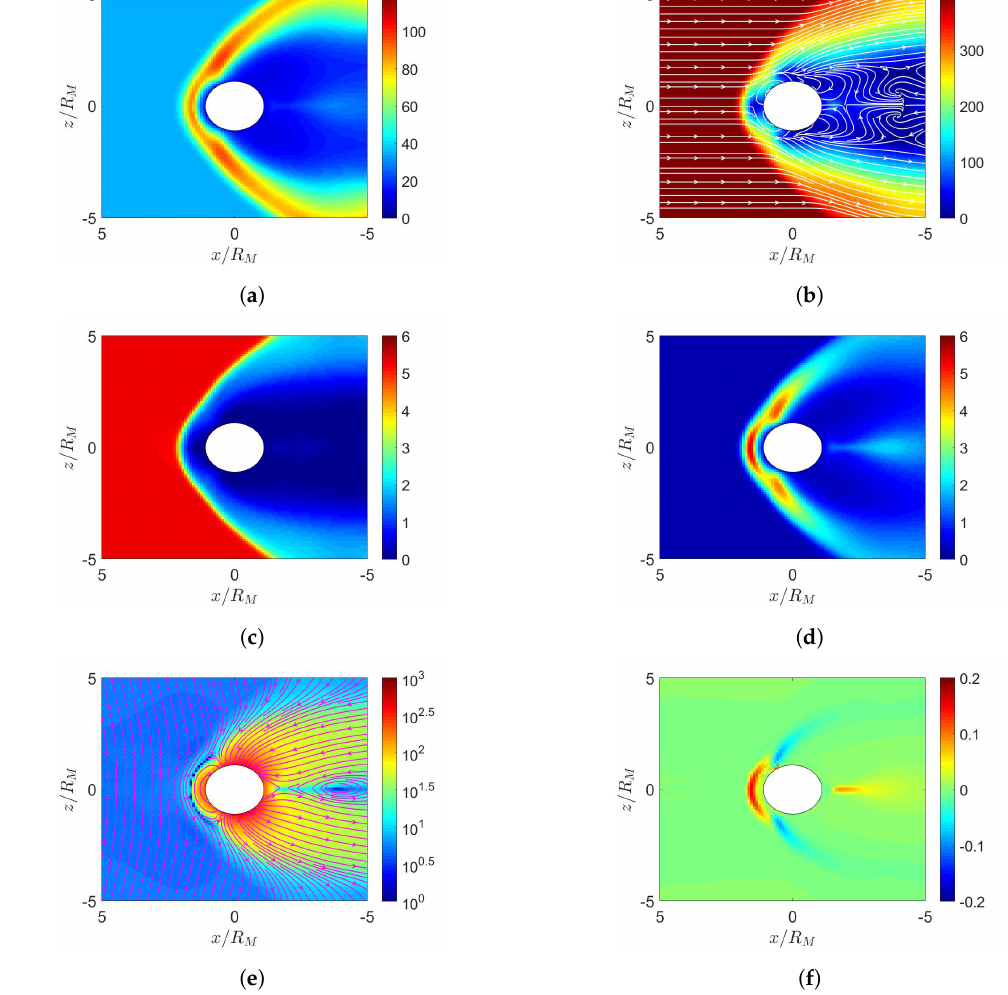
Figure 8. Distributions around Mercury of ( a ) n (cm − 3 ), ( b ) ¯ u xz (km/s), ( c ) magnetosonic Mach number, ( d ) P (nPa), ( e ) ¯ B xz (nT), ( f ) J y ( µ A/m 2 ); southward IMF, t = 1 min 58